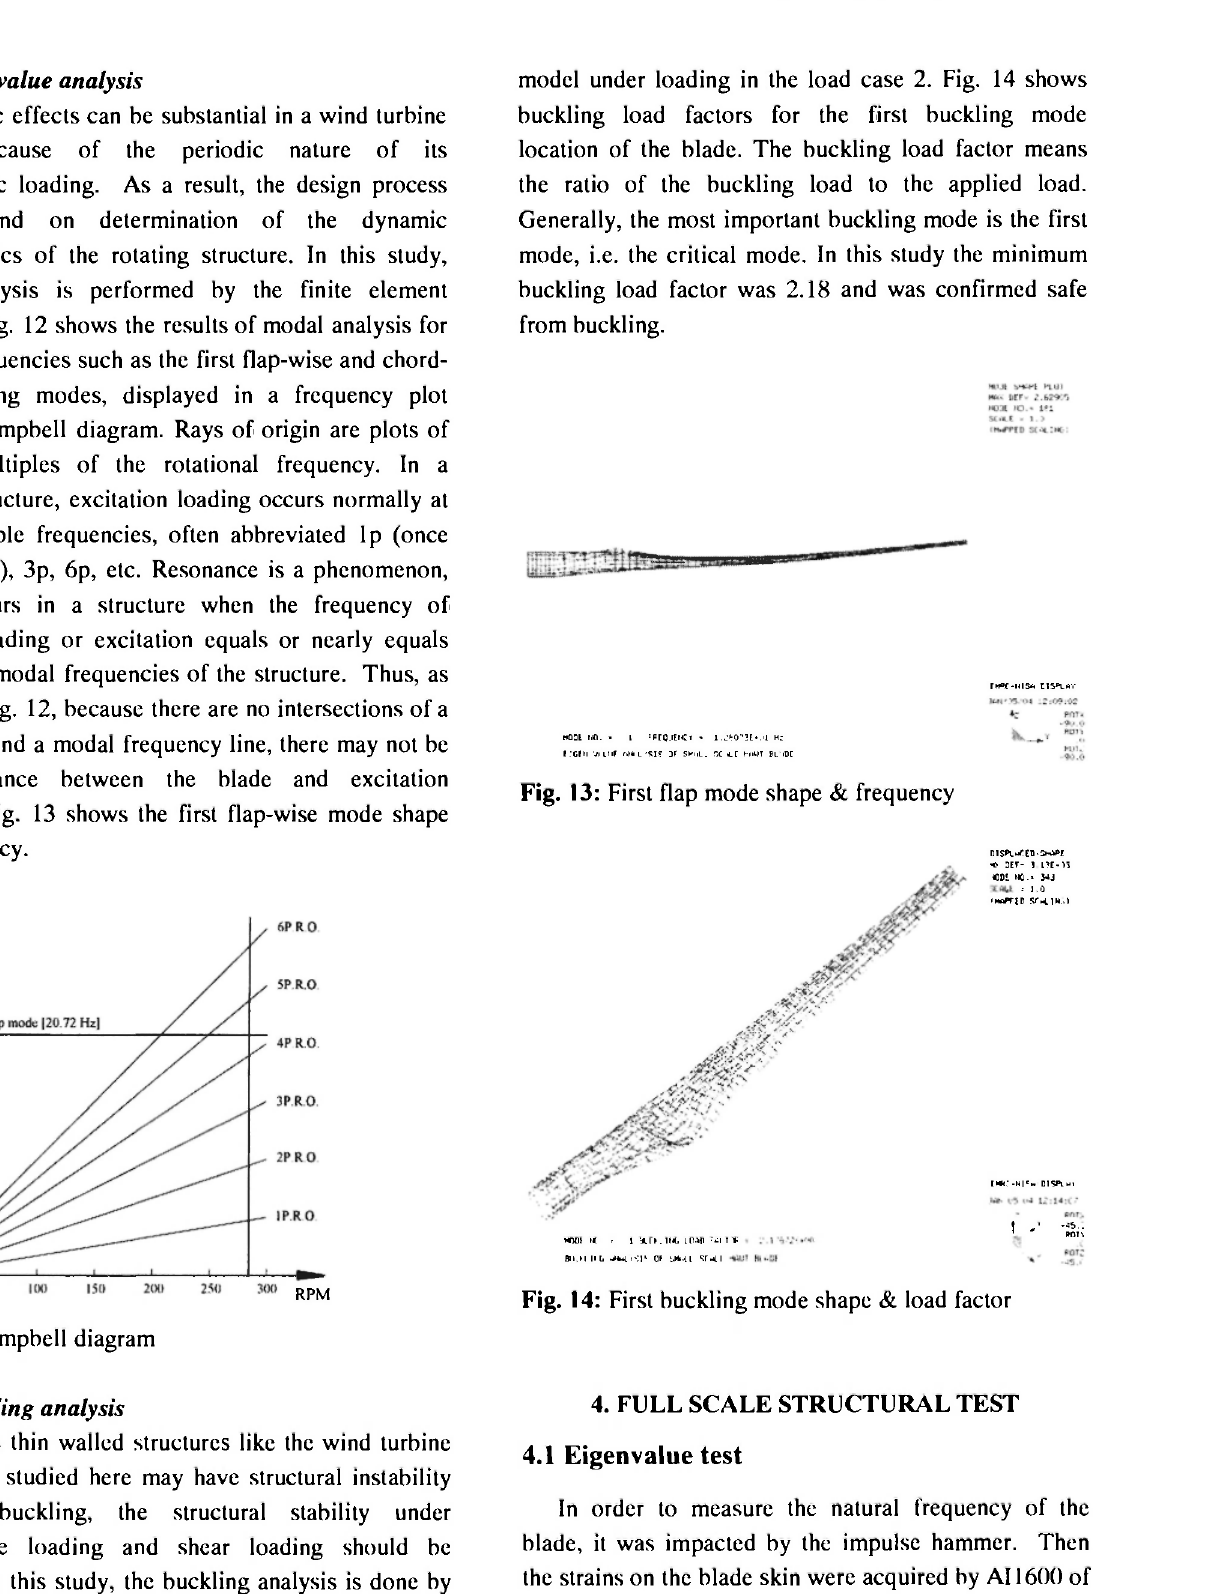
Fig. 12: Campbell